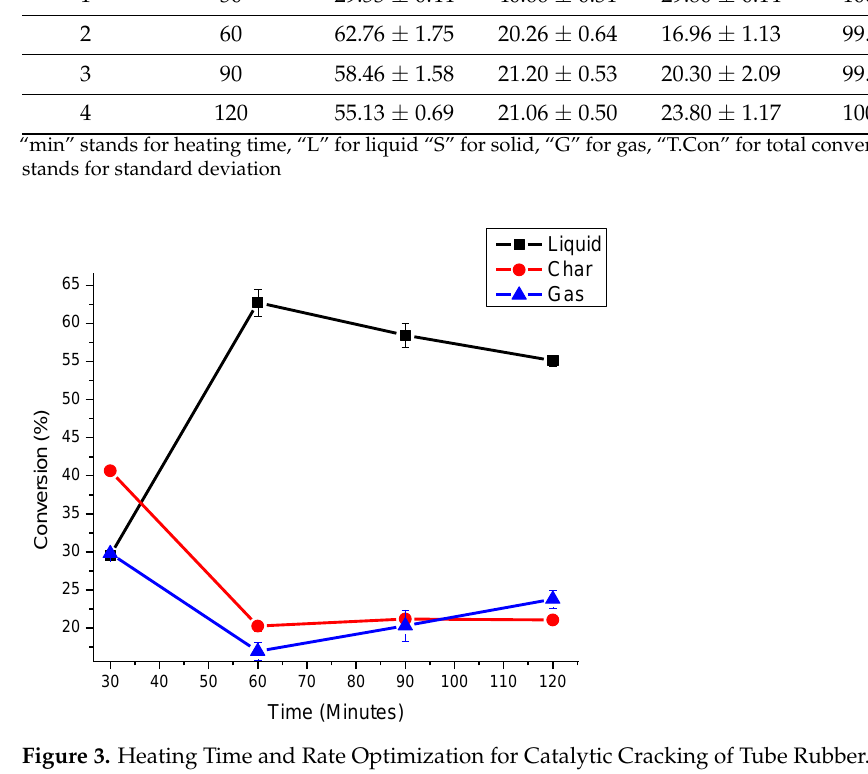
Figure 2. Weight of Catalyst Optimization for Catalytic Cracking of Tube Rubber.